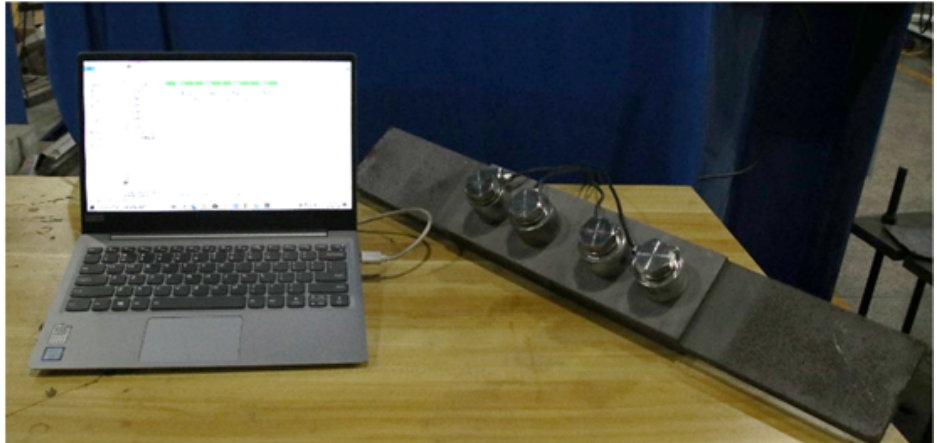
Figure 10. Preload relaxation test setup.